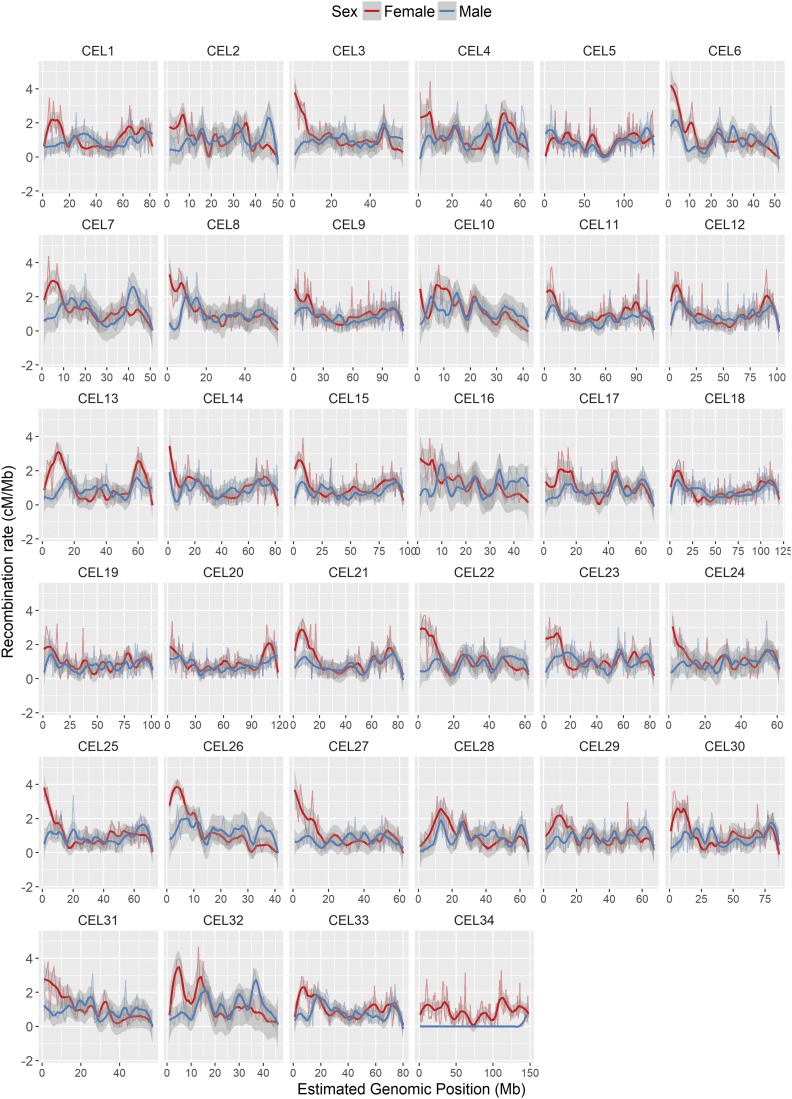
Loess smoothed splines of recombination rates in 1 Mb windows across 33 autosomes for males and females with a span parameter of 0.2. All chromosomes are acrocentric with the centromere at the beginning of the chromosome (Gustavsson and Sundt 1968), with the likely exception of CEL5. CEL34 is the X chromosome, with the pseudoautosomal region at the telomere end.